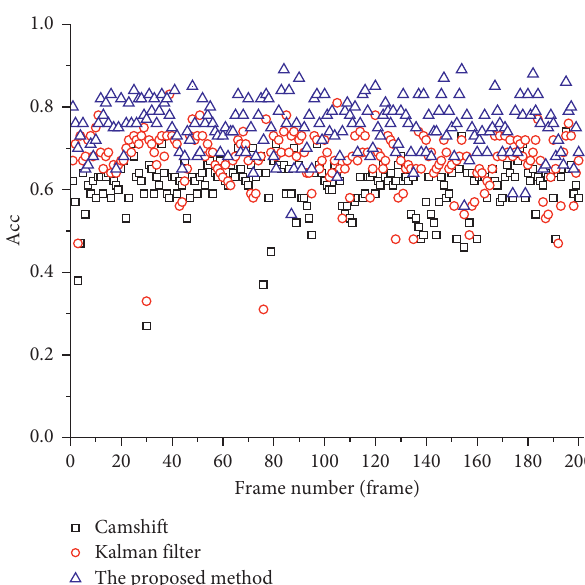
Figure 14: Comparison of target domain coverage accuracy for three algorithms in complex traffic